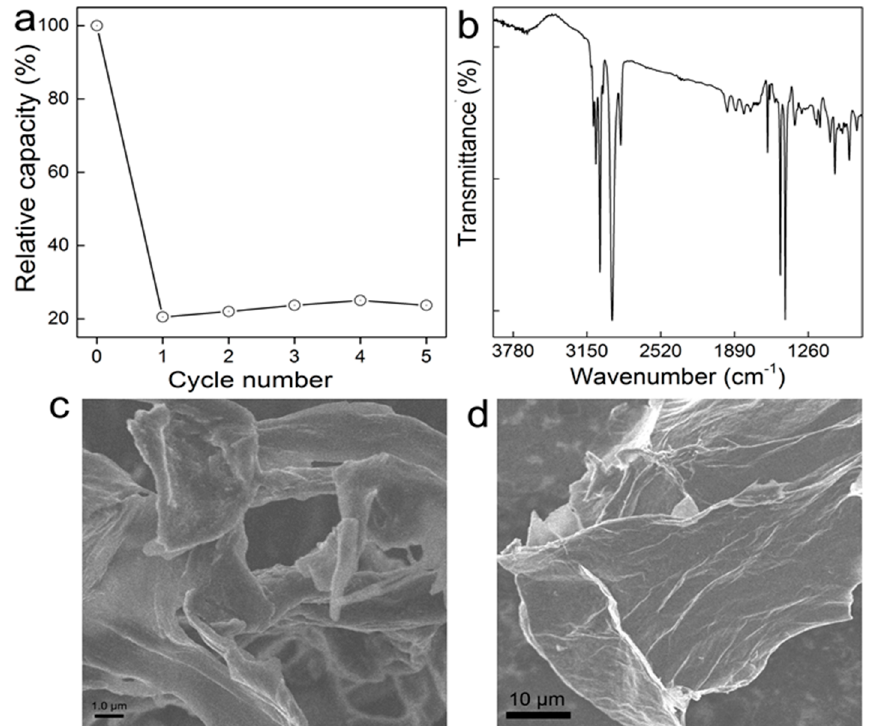
Figure 7. Recycling of MB adsorbed GO-COOH by lyophilization and oven dry treatments. ( a ) Regeneration percentage. Data represent mean ± SD ( n = 3). ( b ) IR of GO-COOH after regeneration. ( c , d ) SEM images of GO-COOH sponge after regeneration.